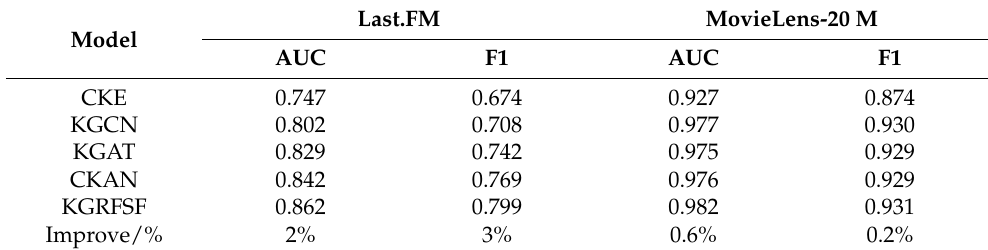
Table 3. Recommendation accuracy comparison experiment results.